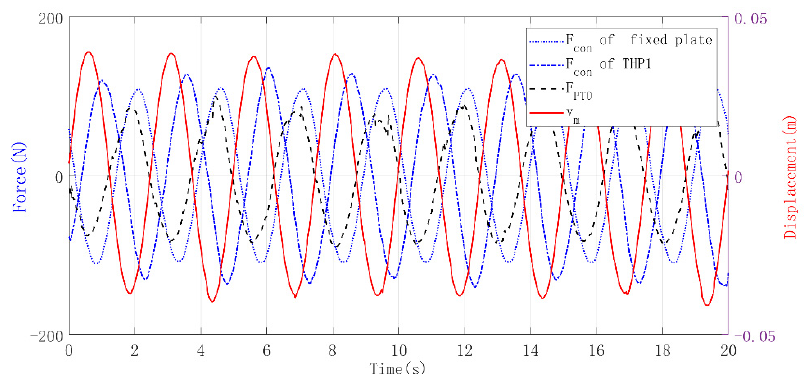
( b ) Figure 17. The equivalent hydrodynamic parameters of THP3 with different load resistance. ( a )